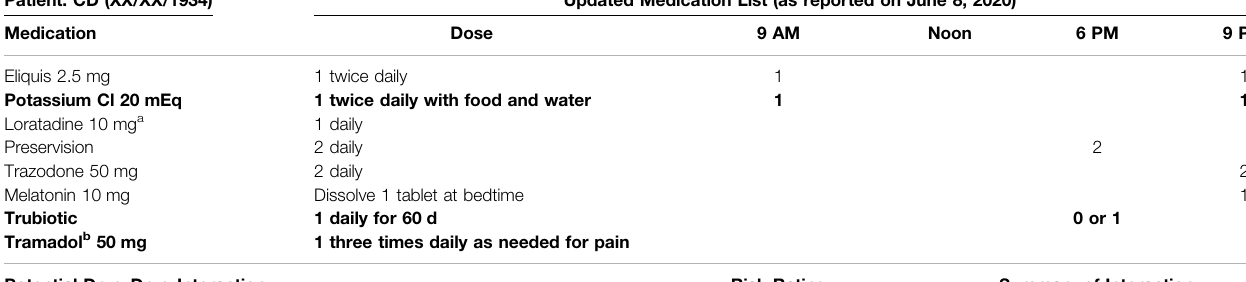
TABLE 2 | Updated Medication List (as reported on June 8, 2020). Patient: CD